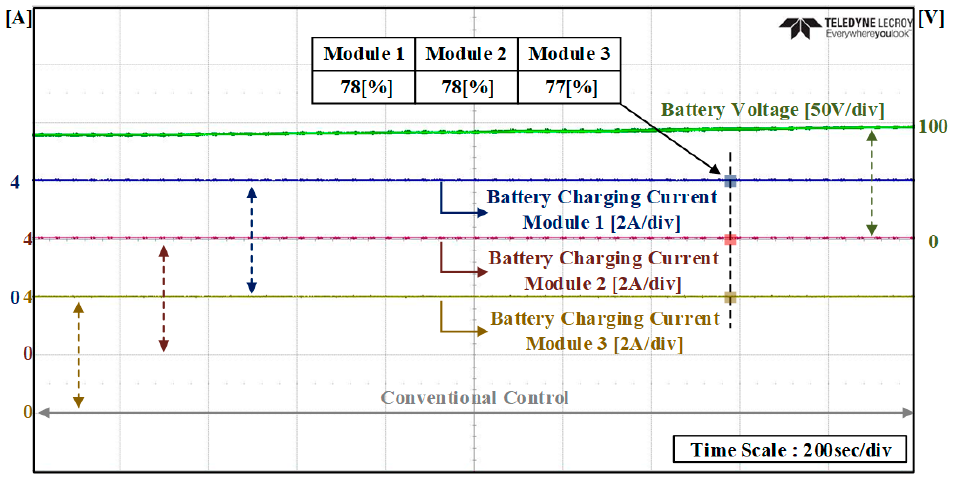
Figure 14. Battery charging voltage, the current waveform of ESS.